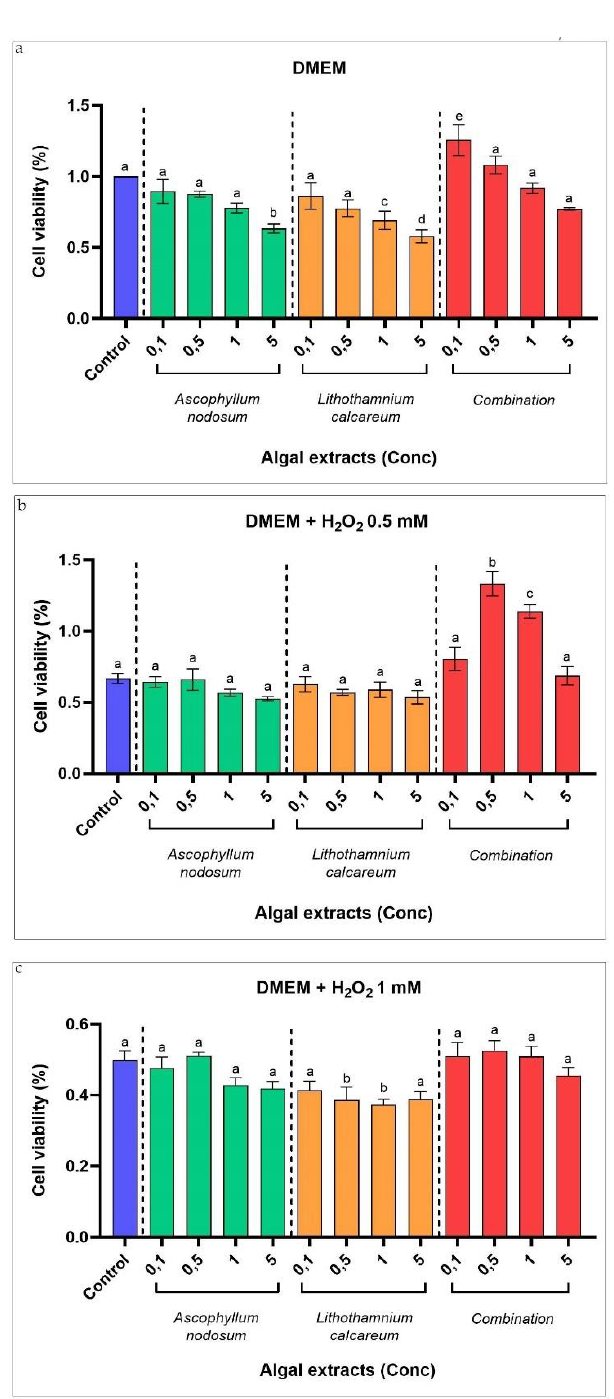
Figure 4. Viability of intestinal IPEC-J2 cells. ( a ) Dose − response curves with different concentrations of Ascophyllum nodosum, Lithotamnium calcareum and the combination of both algae; ( b ) Viability of IPEC-J2 cells challenged with H 2 O 2 0.5 mM and pre-treated with Ascophyllum nodosum, Lithotamnium calcareum and the combination of both algae; ( c ) Viability of IPEC-J2 cells challenged with H 2 O 2 1 mM and pre-treated with Ascophyllum nodosum, Lithotamnium calcareum and the com- bination of both algae. Data are shown as means and standard deviations. a–e Means ( n = 3) with different superscripts are significantly different (Treatment p <